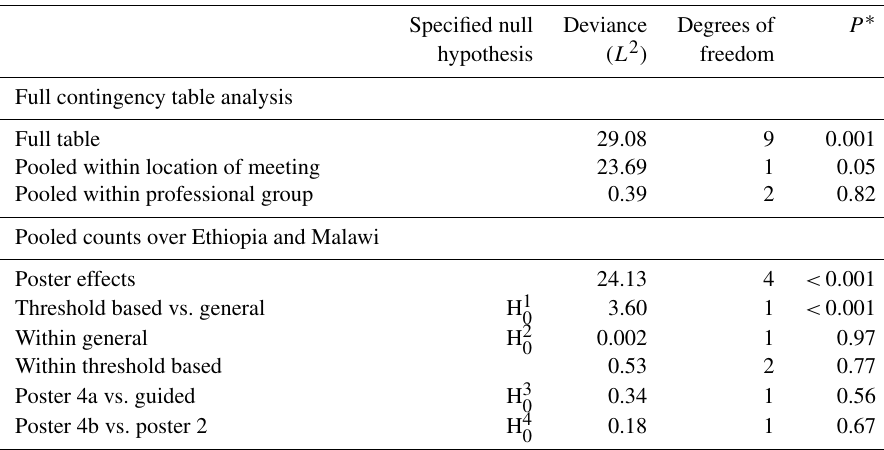
Table 9. Analysis of Q6 according to the location of the meeting, professional group and methods that the latter tested on pooled counts over Ethiopia and